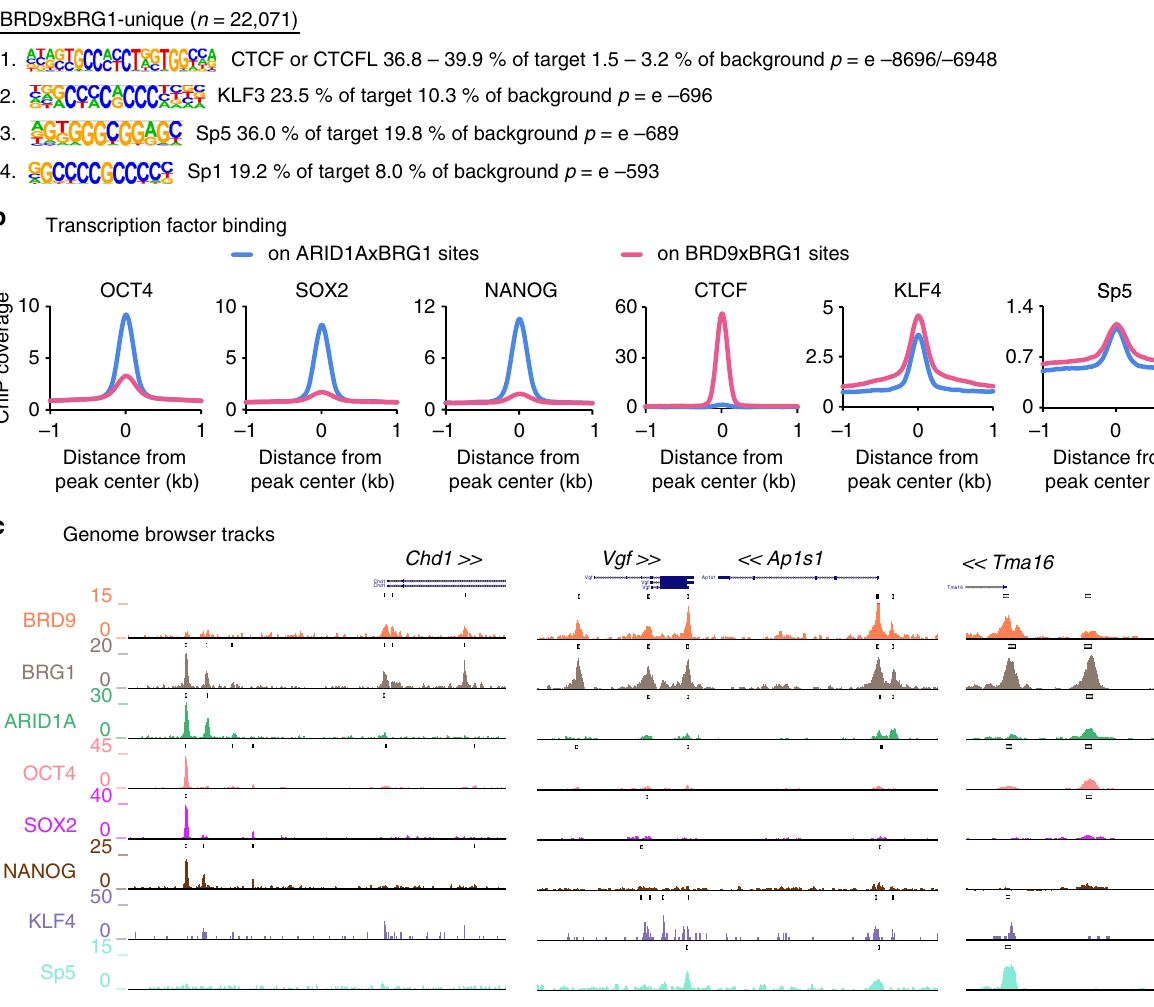
Fig. 4 GBAF and esBAF are co-bound by different pluripotency transcription factors. a Signi fi cance of enriched motifs for BRG1 sites uniquely bound by either ARID1A (top) or BRD9 (bottom). p Values were calculated using cumulative binomial distribution ( fi ndMotifsGenome.pl in HOMER). b Histogram of ChIP reads of the indicated transcription factor (TF) ± 1 kb surrounding the peak center of sites that are co-bound by either ARID1A and BRG1 or BRD9 and BRG1. c Representative genome browser tracks showing co-binding of BRD9 and BRG1 with either KLF4 or Sp5 at promoters (middle and right, respectively) or ARID1A and BRG1 with OCT4, SOX2, and NANOG at distal sites